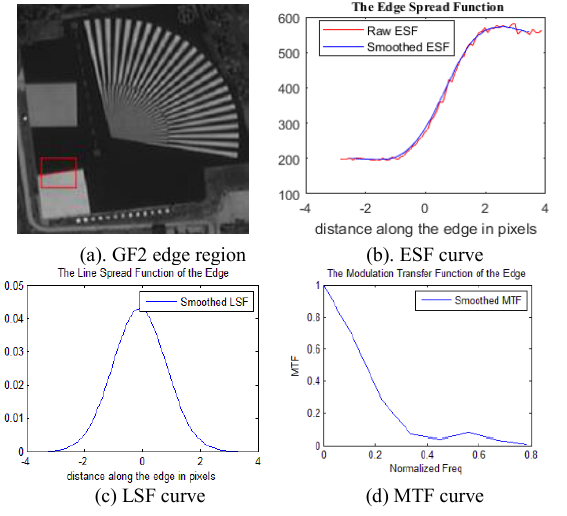
Figure 1. The process of MTF